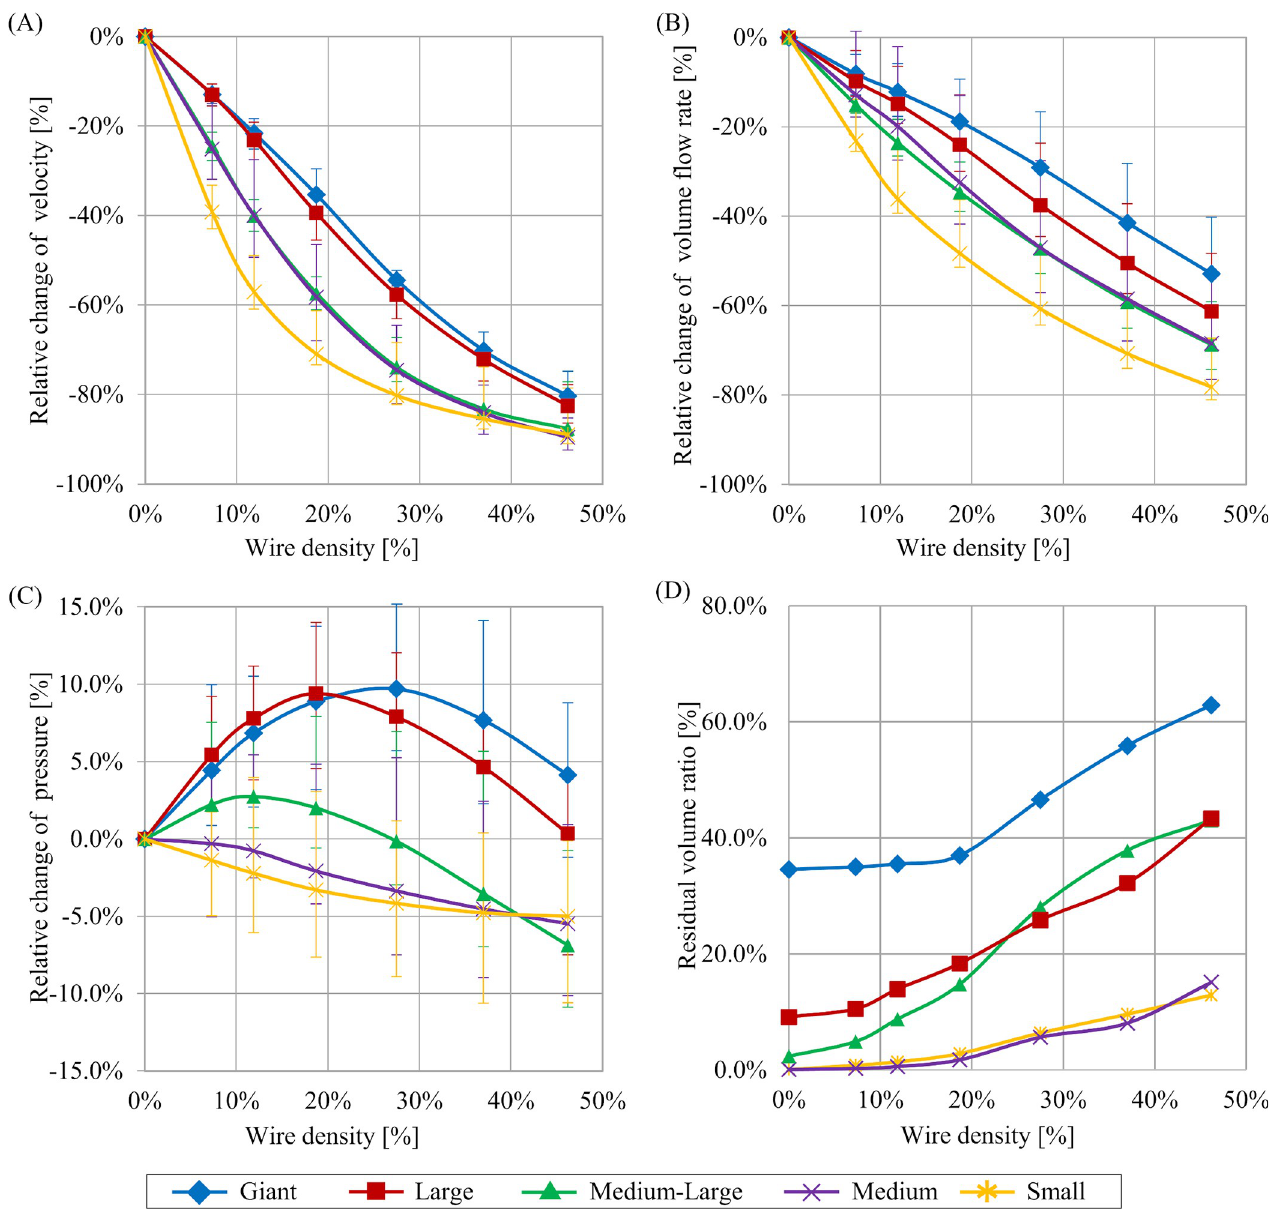
Fig 4. Relationships between each parameter relative change and stent wire mesh density. The range of relative change over the second pulsation observed in unsteady flow simulation are shown in whiskers. A) Results of relative change of velocity ( RC-V ). B) Results of relative change of volume flow rate ( RC-VFR ). C) Results of relative change of pressure ( RC-P ). D) Results of residual volume ratio ( RVR